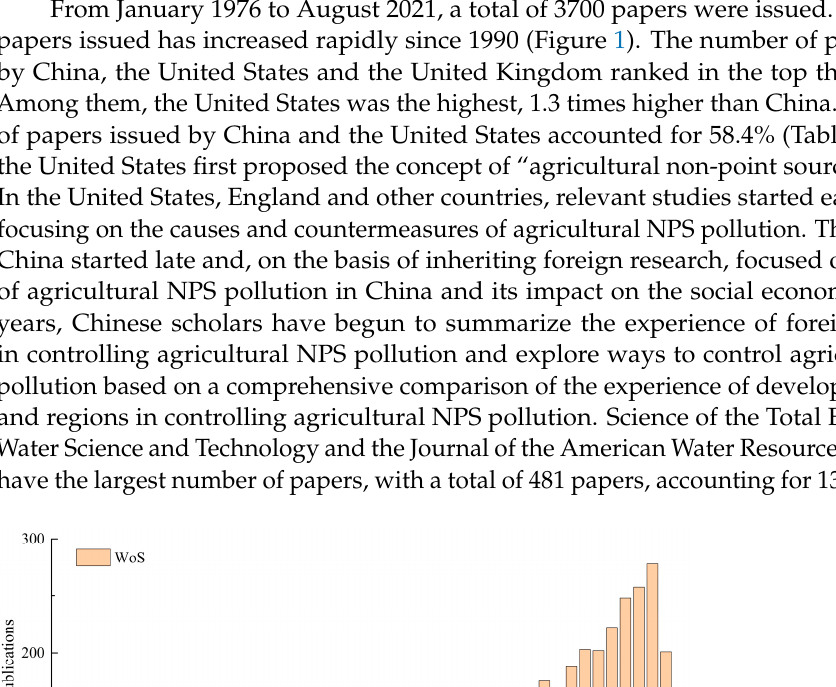
96 Table 2. Top 10 journals. No.